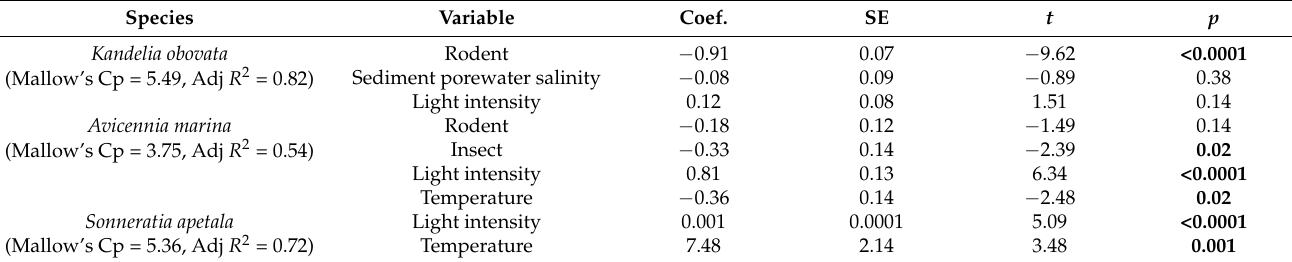
Table 2. Results of the best multiple regression models for survival of three mangrove species across both sites. Significant p -values ( p < 0.05) are in bold. The best models were chosen based on R 2 and Mallow’s Cp and included some variables that were not statistically significant. Other reasonable models are shown in Supplementary Table